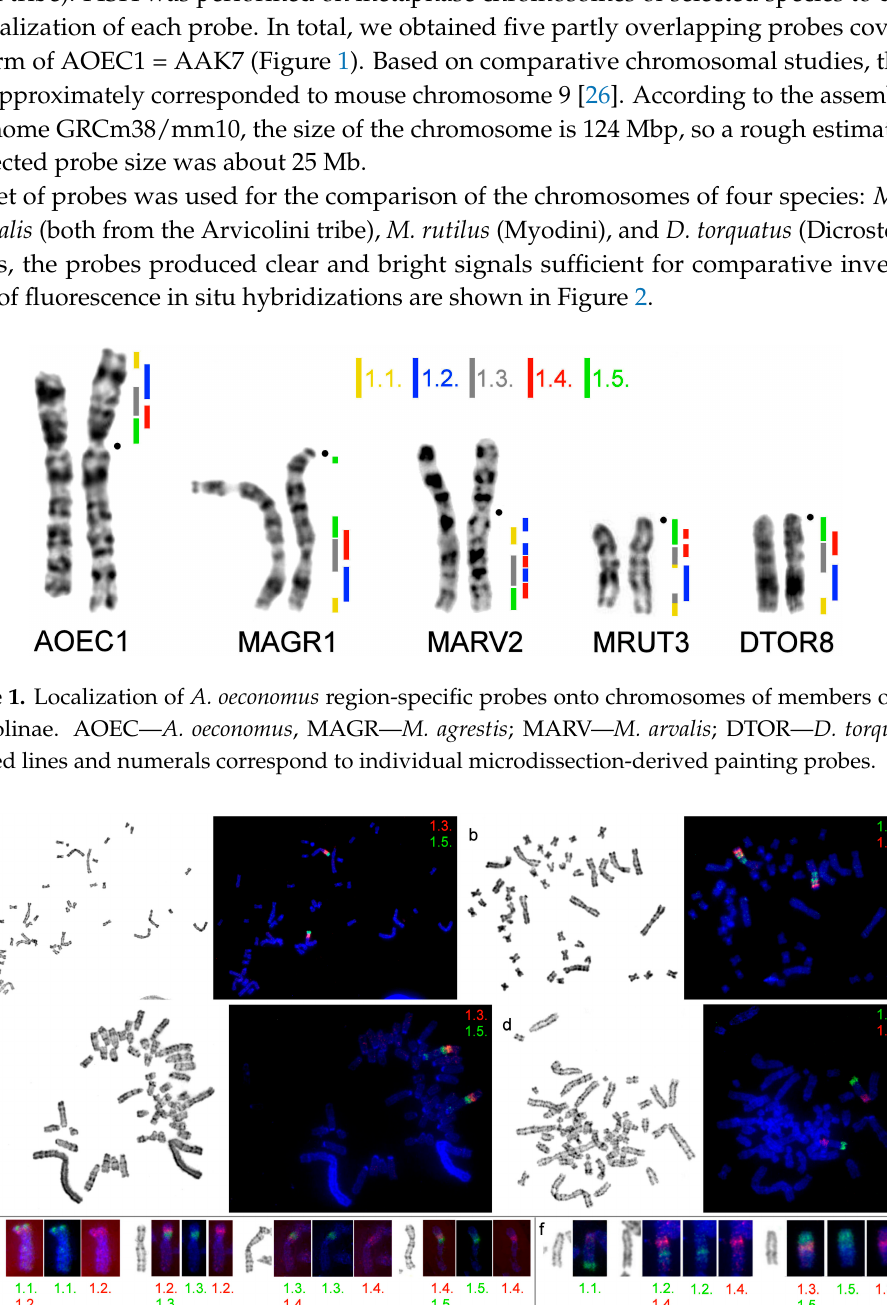
Figure 2. FISH of microdissection-derived painting probes on chromosomes of different species: ( a ) M. arvalis ; ( b ) M. arvalis ; ( c ) M. agrestis ; ( d ) D. torquatus ; ( e ) A. oeconomus ; ( f ) D. torquatus. G-banded chromosomes are shown on the left, the image with localization of both probes—on the right. Separate images for the green and red signals are presented ( e , f ). Color-coded number of the probe is shown for each image.